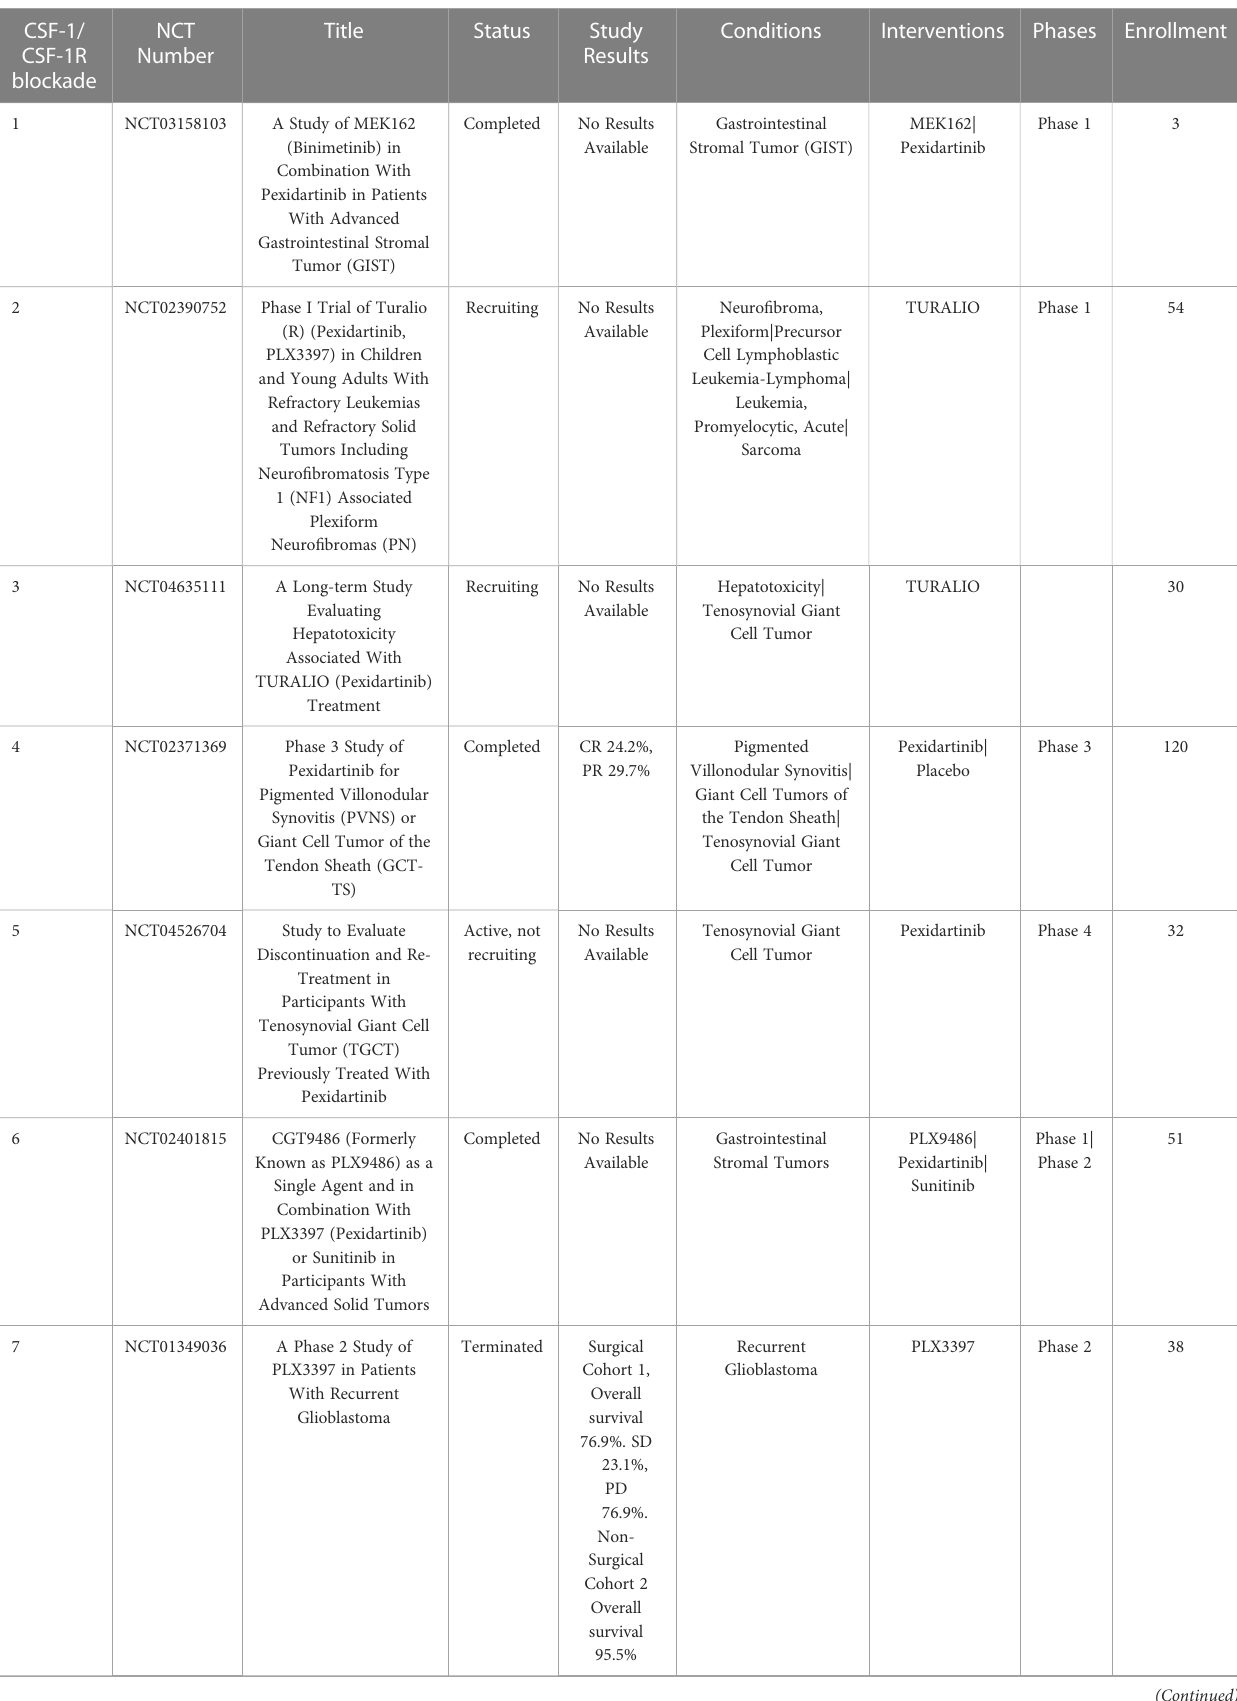
TABLE 1 US clinical trials in cancer using Colony-stimulating factor 1 receptor (CSF-1R) blockade as intervention. CSF-1/ CSF-1R